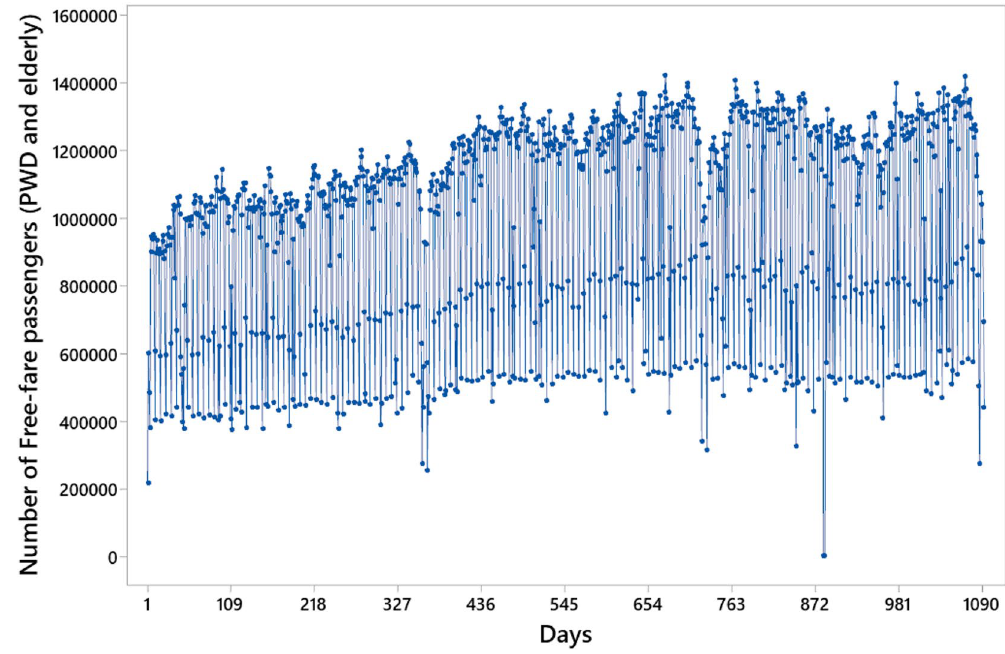
Figure 4. Original series with the number of PWD and elderly passengers riding the public bus transport system of São Paulo, Brazil, from January 2015 to December 2017 (daily